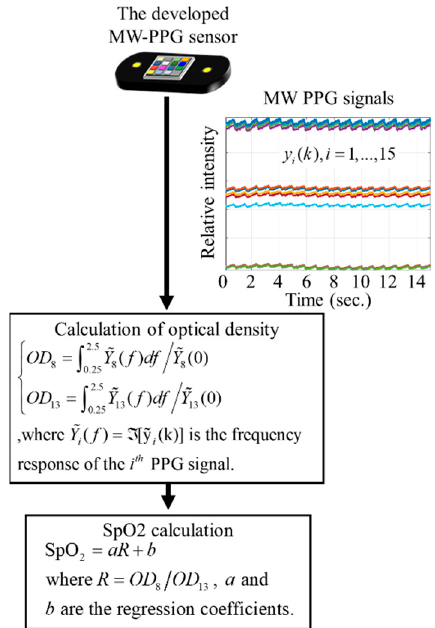
Figure 4. Signal processing procedure of SpO 2 measurement using the MW-PPG sensor developed.